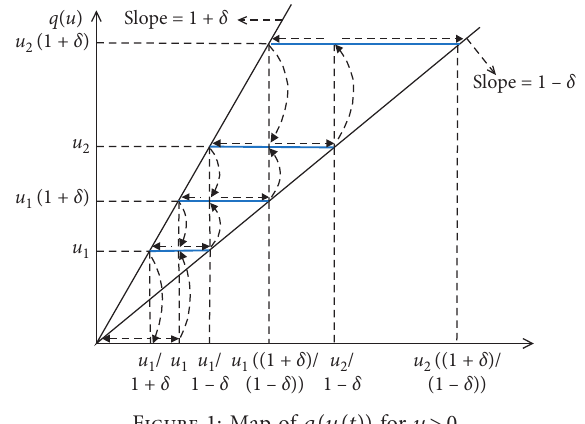
Figure 1: Map of q ( u ( t )) for u >